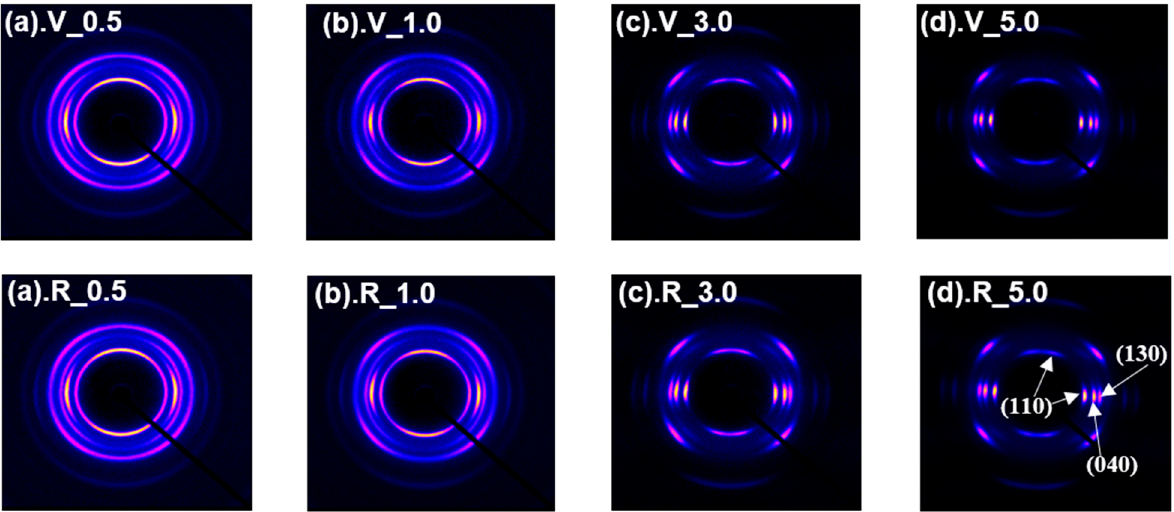
Figure 8. WAXD patterns for the fibers from virgin ( upper row ) and recycled ( lower row ) PP, melt spun at different take-up velocities. The take-up velocities were ( a ) 0.5 km/min, ( b ) 1.0 km/min, ( c ) 3.0 km/min and ( d ) 5.0 km/min.